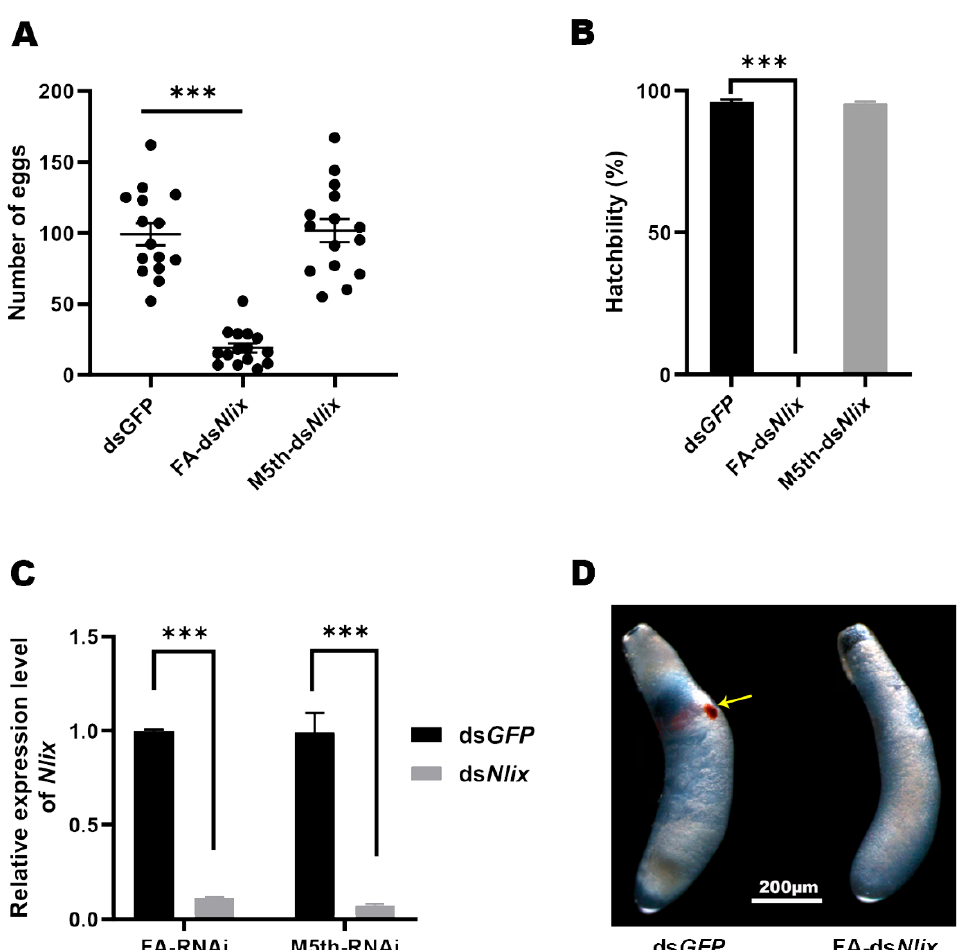
Figure 7. Nlix was indispensable for female fecundity and embryonic development. ( A ) The offspring number of ds Nlix - treated females (FA-ds Nlix ) after mating with ds GFP -treated males, or the number of eggs laid by the ds GFP -treated females after mating with the males treated with ds Nlix at 5th instar (M5th-ds Nlix ). ds GFP was injected as a negative control. The newly emerged female or male individuals were injected with dsRNA. ( B ) The egg hatching rate after RNAi treatment. Fifteen replications were administered. ( C ) The transcript level of Nlix significantly decreased after dsRNA treatment. The results are shown as the mean ± SEM. Student’s t -test was used to compare the differences from ds GFP (*** p < 0.001). ( D ) The embryonic development after knockdown of Nlix . The red eye pigmentation was indicated by the yellow arrow.